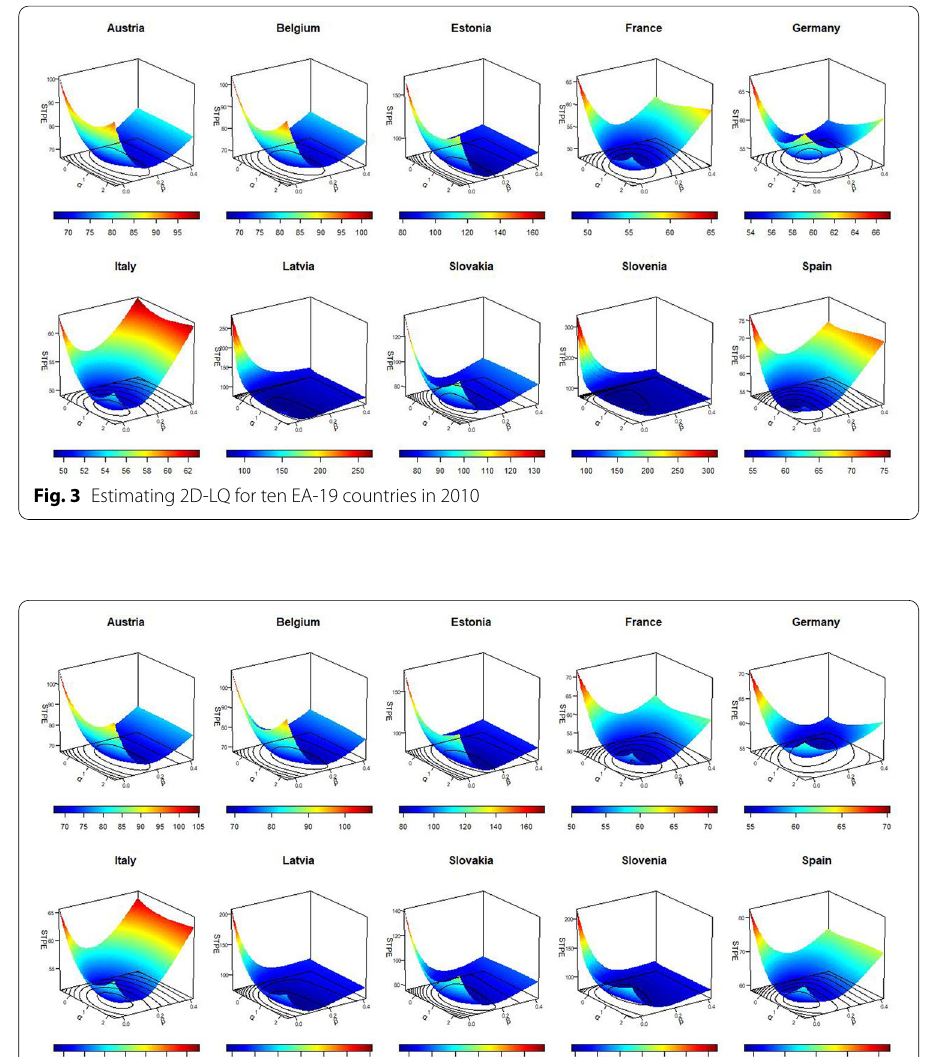
Fig. 4 Estimating 2D‑LQ for ten EA‑19 countries in